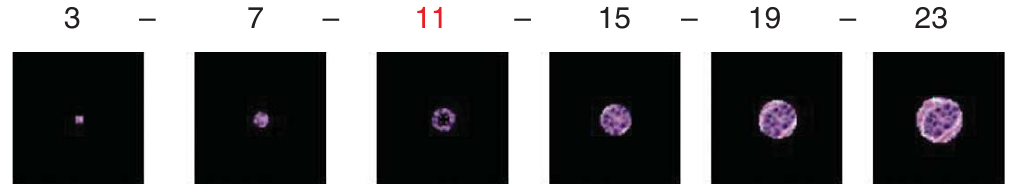
Supplementary Figure 1. Vector images for the various ring sizes. At ring size greater than 15 pixels in diameter, one can observe both the micropapillary nest and adjacent stroma in the chosen vector predicate image. A vector size of 3 or 7 pixels includes only a subset of the nest. A vector size of 11 demonstrates a generic feature motif that encompasses multiple nuclei within the nest of cancer